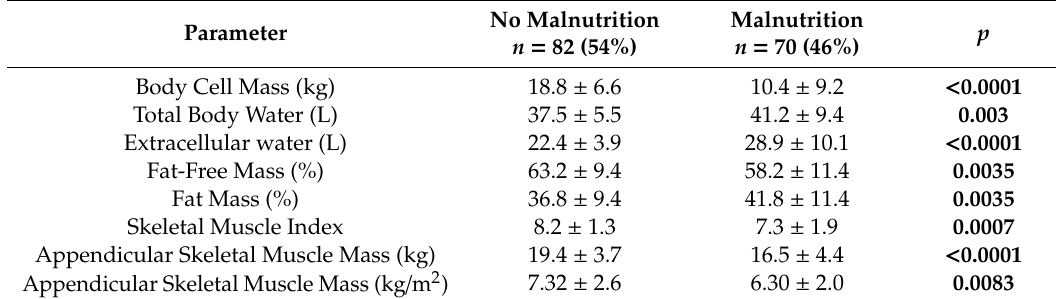
Table 2. Bioelectrical impedance analysis parameters in patients stratified according to the Global Leadership Initiative on Malnutrition